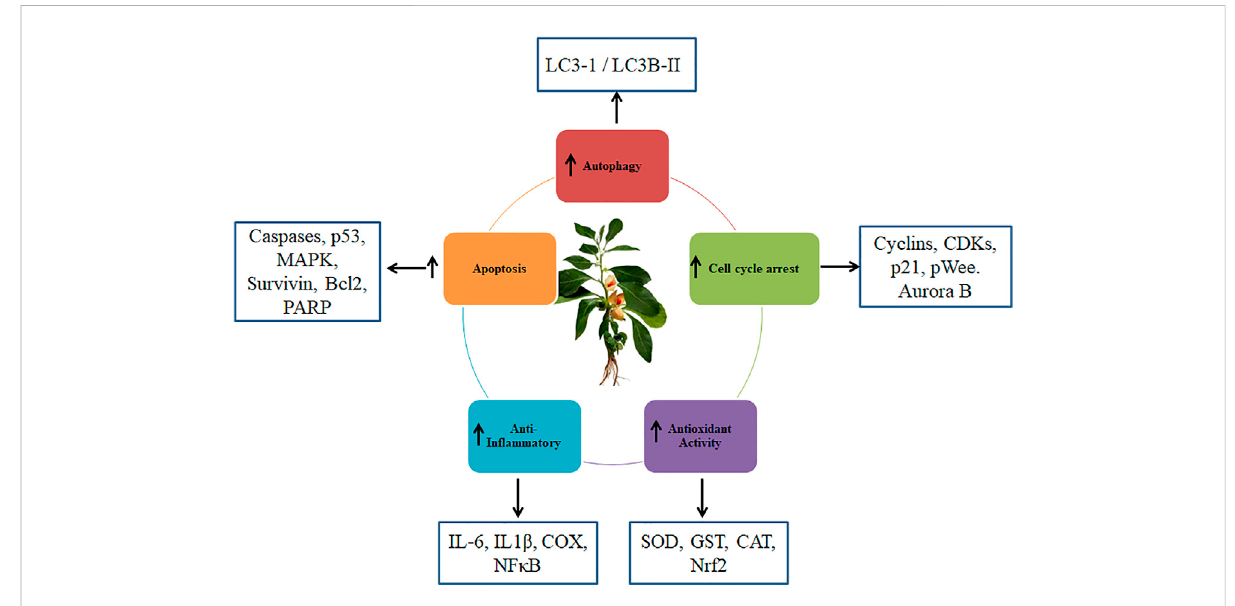
FIGURE 3 Effect of Withania somnifera on different pathways involved in